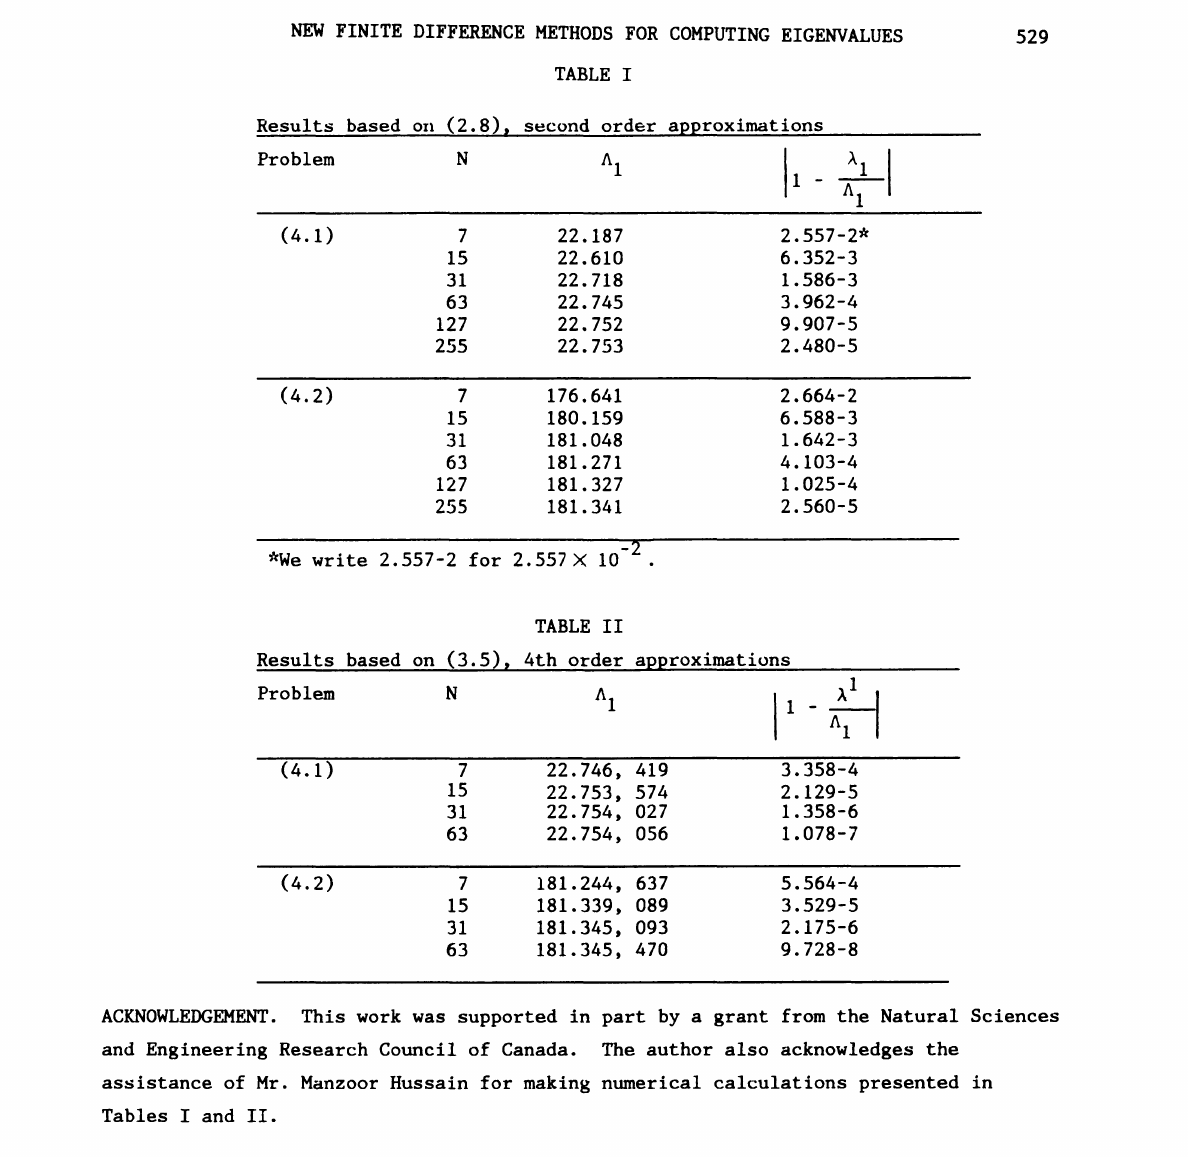
Results based on (3.5) 4th order